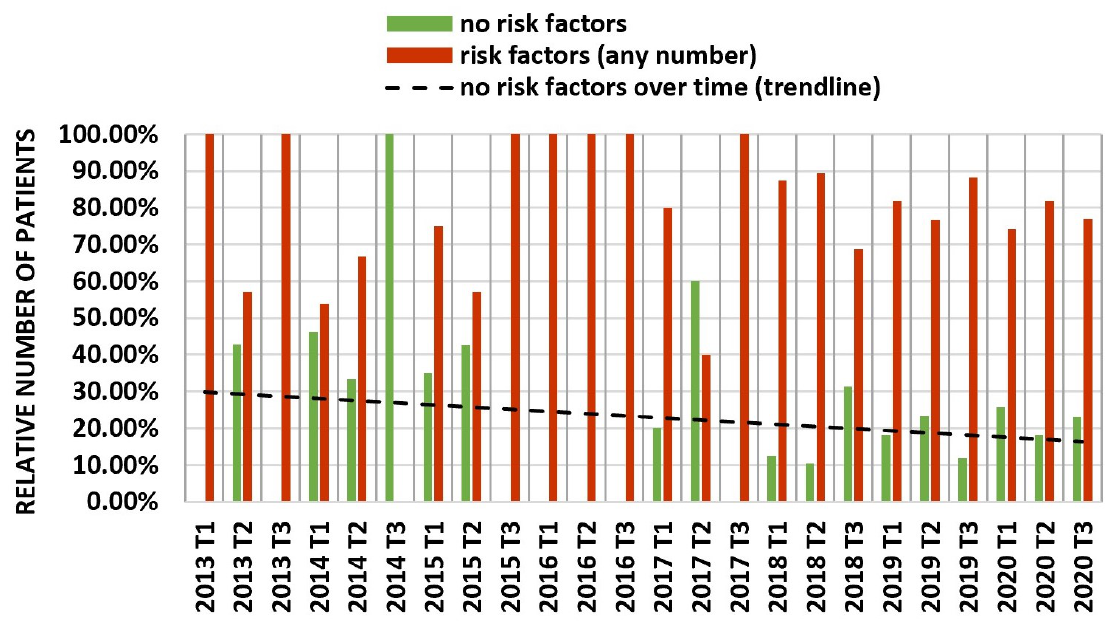
Figure 7. Presence or absence of cardiovascular risk factors. The percentage of patients without any cardiovascular risk factor (left ventricular ejection fraction < 50%, arterial hypertension, diabetes mellitus, chronic kidney disease) is compared to the percentage of patients with ≥1 cardiovascular risk factor for every four-month period over time including trendline analysis.